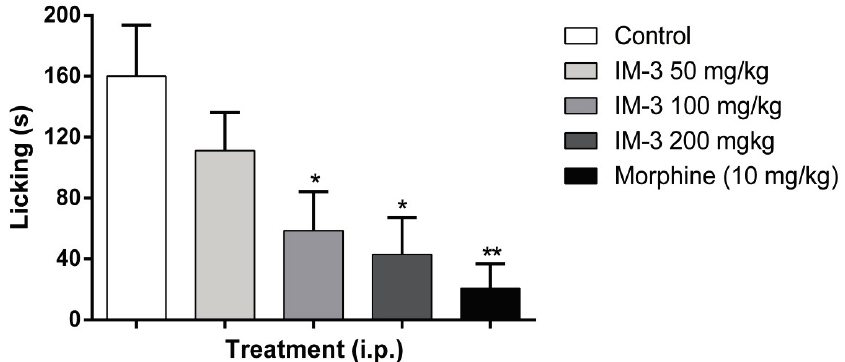
Figure 3. Effect of IM-3 on the first phase of the formalin test in mice ( n = 8). ANOVA followed by Dunnett’s test. *** p < 0.001.